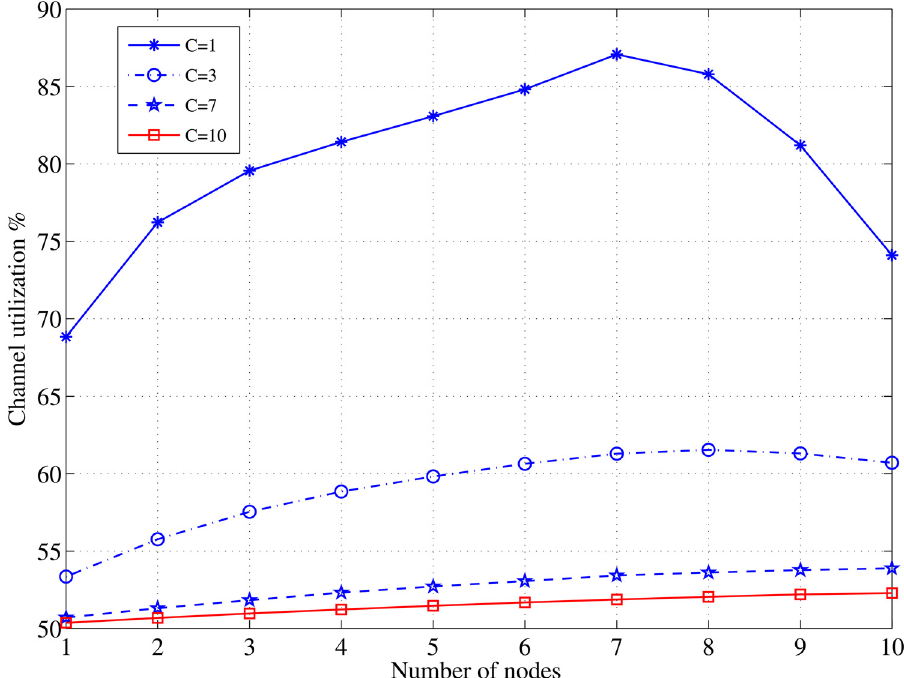
Fig 12. Channel utilization ratio as a function of node density for different values of C ; τ off = 0.5, L = 1000 [bits].